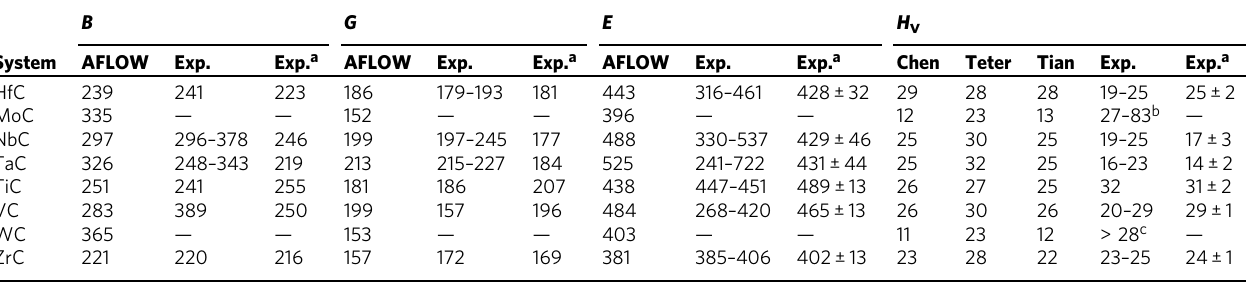
The AFLOW values are calculated using the Voigt-Reuss-Hill average and the Automatic Elasticity Library (AEL) module 53 , whereas H V is estimated using three different models described in the literature. These results are compared with two sets of available measured data, obtained from the literature 72,73 and the current experiments. Units: B , G , E , and H V in (GPa)